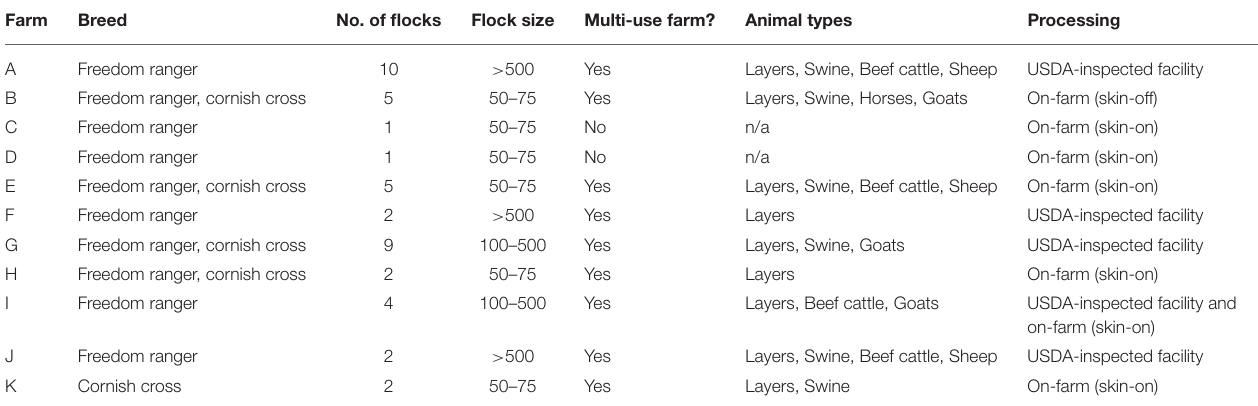
TABLE 1 | Comparison of the 11 all-natural, antibiotic-free, pastured broiler farms included in this